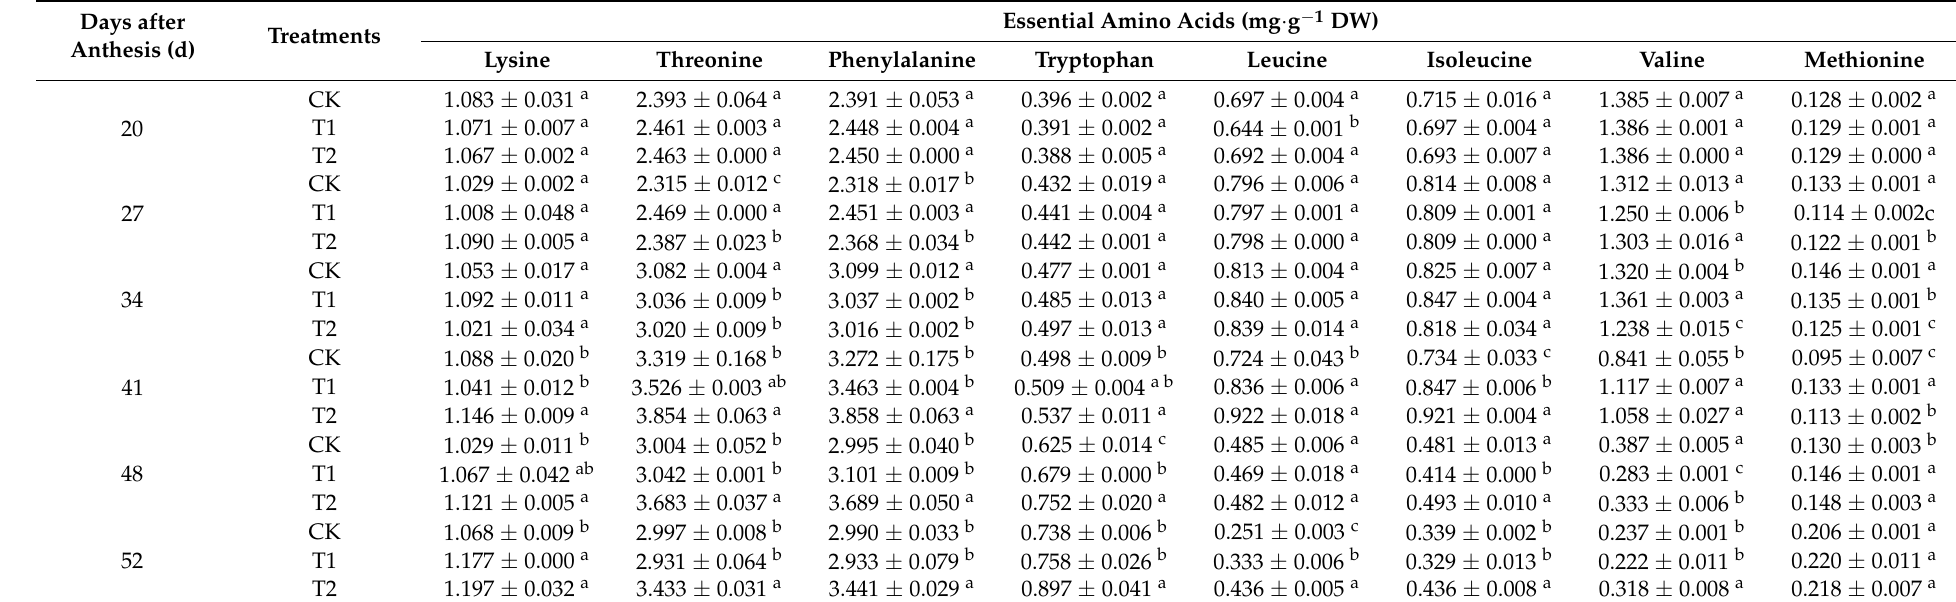
Table 3. Effects of exogenous melatonin on the content of essential amino acids in tomato